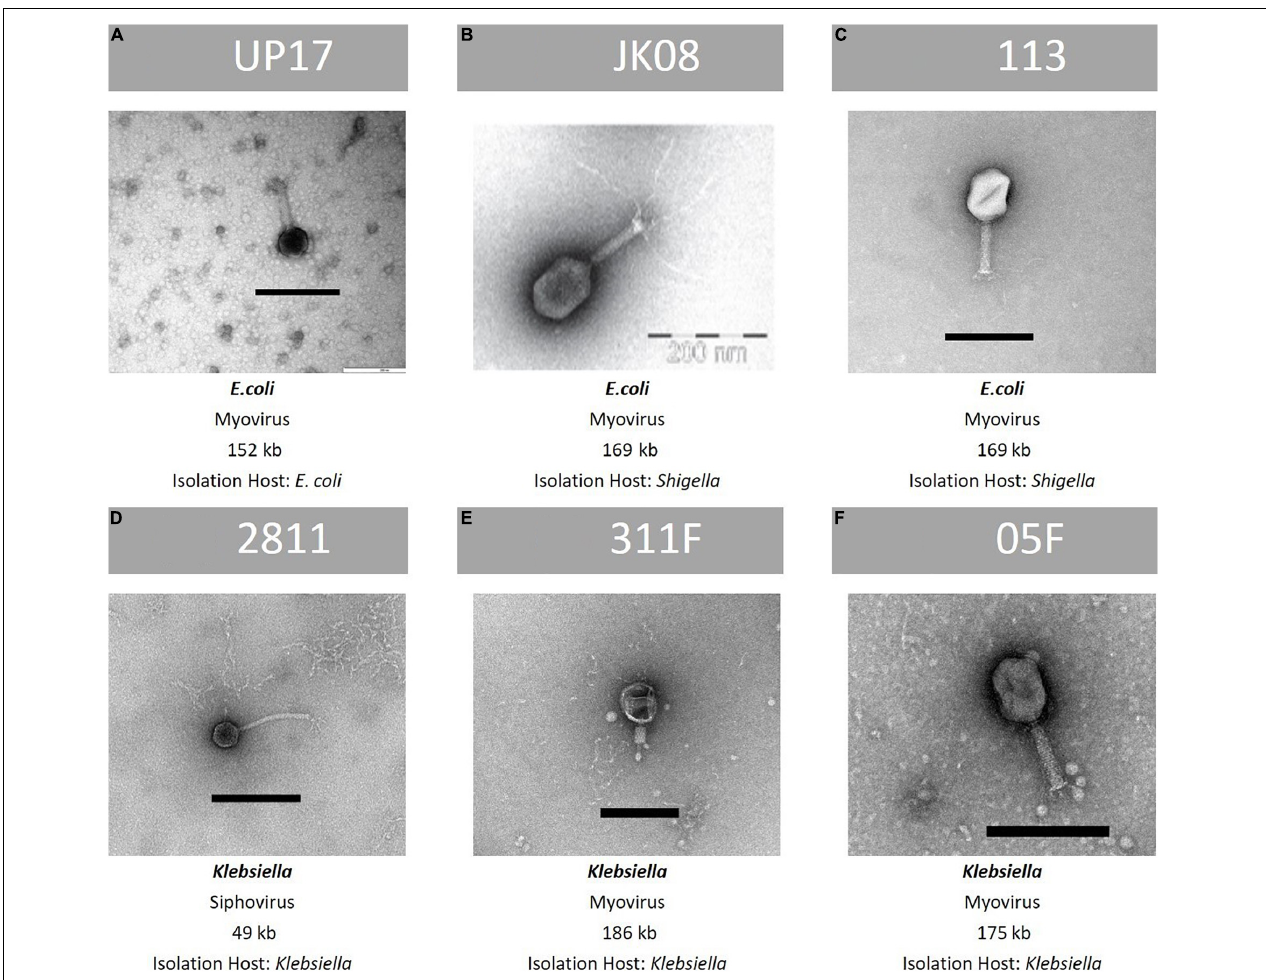
FIGURE 2 | Summary of key features of the final six phages within the ESBL cocktail—TEM image, family classification, genome size and species of propagation host. From top row left to right, (A) : phage UP17, (B) : phage JK08, (C) : phage 113. From bottom left to right: (D) : phage 2811, (E) : 311F, and (F) : phage 05F. Black bar represents 200